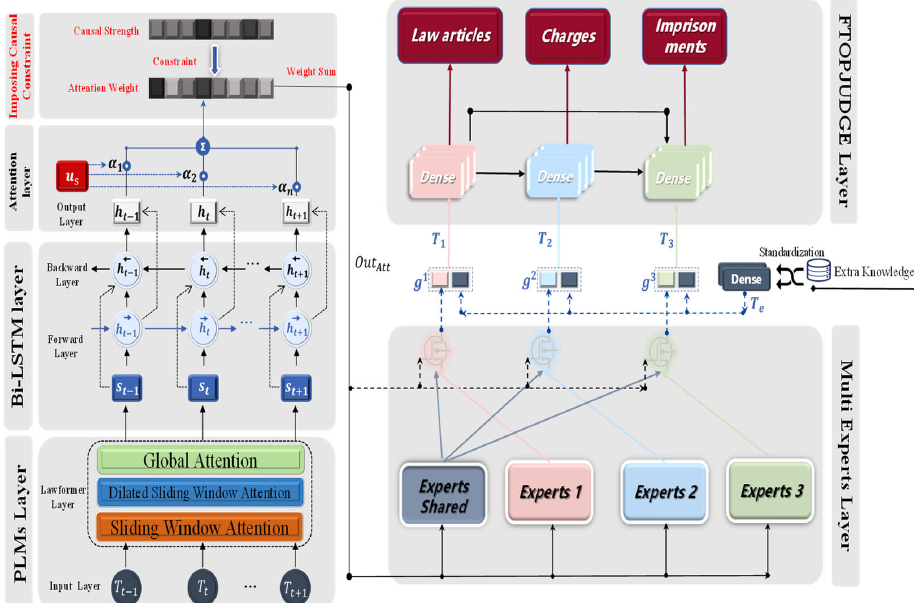
Figure 1. Overall structure of the model.